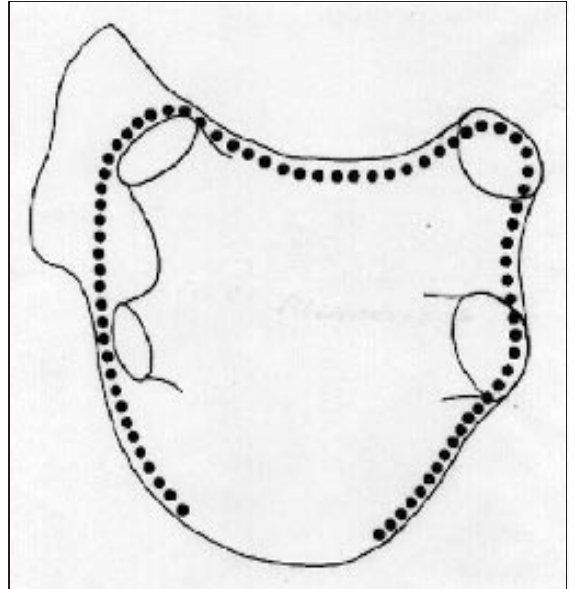
Fig. 4 - Linhas no átrio esquerdo.